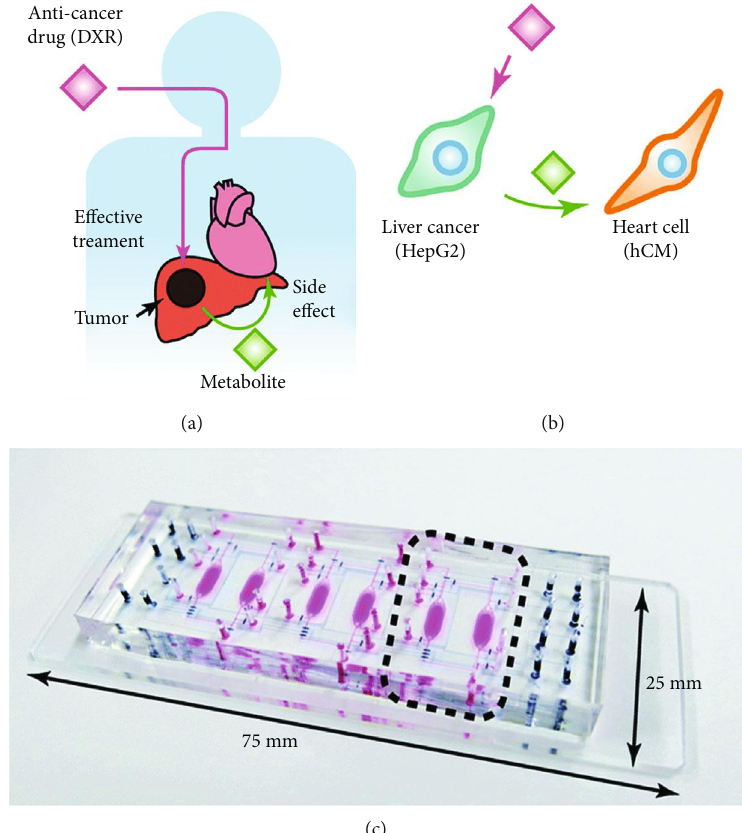
Figure 17: Integrated heart/cancer on a chip, (a, b) Communication between liver cancer cells and healthy heart cells through exchange of metabolites and the side e ff ects of an anticancer drug. (c) Photograph of an actual iHCC fabricated on a glass slide. Reproduced (or adapted) with permission [100], ©2017, Royal Society of